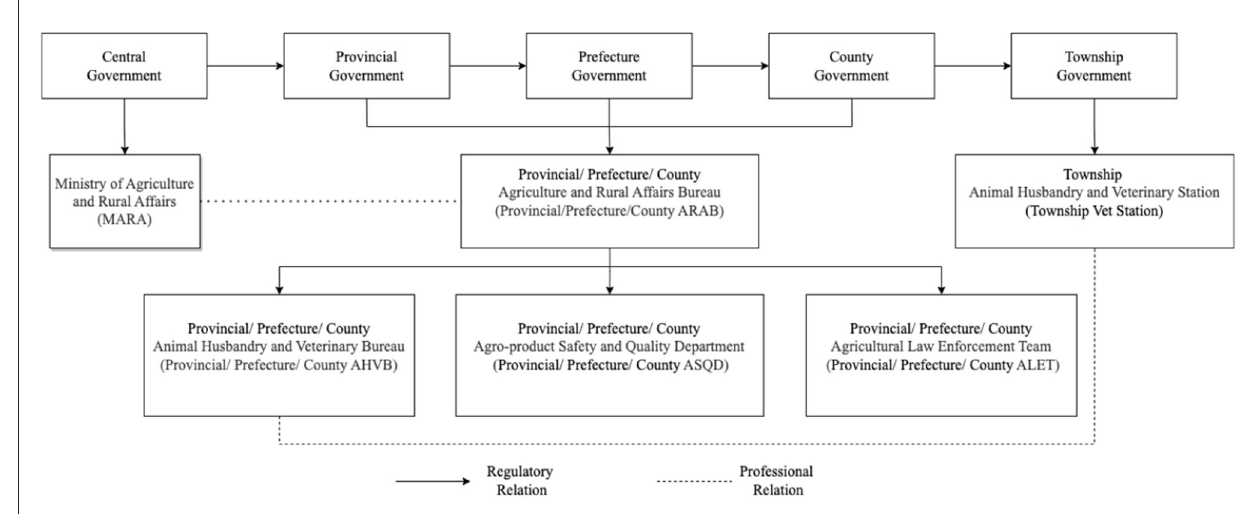
FIGURE1 Governance system of veterinary drug use in animal meat production in China.